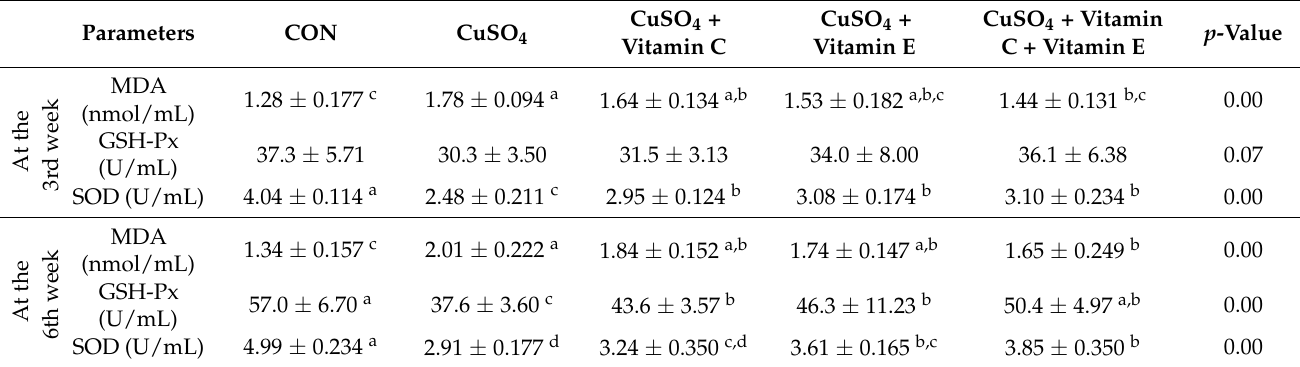
Table 5. Impact of single or combined supplementation of vitamin C and E on the serum oxidative stress indicator and antioxidant status of CuSO4-intoxicated broiler chickens (mean ± SD, n =